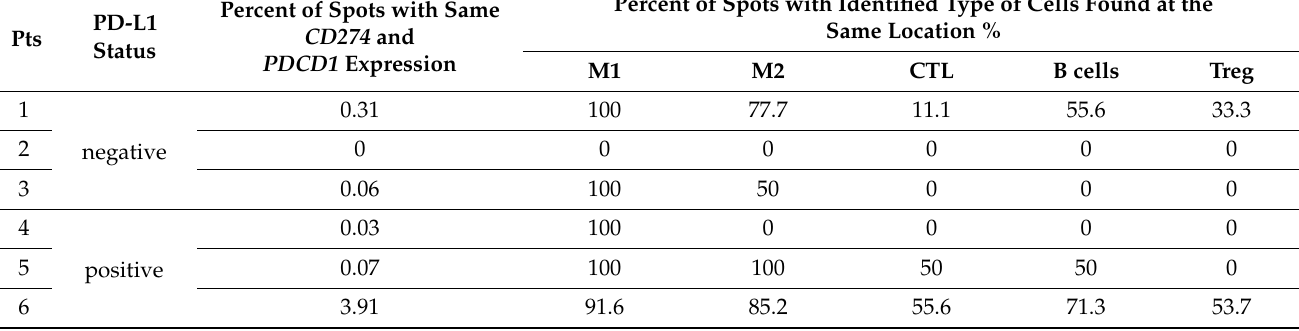
Table 2. Percentage of spots with immune cells found at the same location with CD274 and PDCD1 co-expression in PD-L1-negative and PD-L1-positive tumors. Percent of Spots with Identified Type of Cells Found at the Same Location %